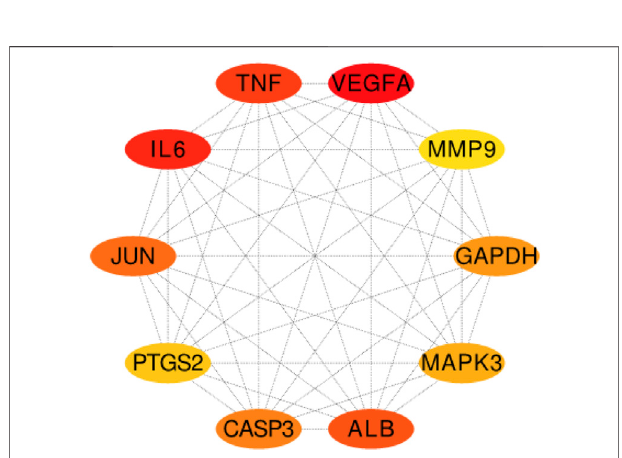
FIGURE 6 | The top 10 Hub target genes of PPI were obtained through MCC function. The color gradually changes from yellow to red; the closer to the red target gene, the more important it is. They are, respectively, P15692 (VEGFA), P05231 (IL-6), P01375 (TNF), P02768 (ALB), P05412 (JUN), P42574 (CASP3), P04406 (GAPDH), MAPK3 (P27361), P35354 (PTGS2), and MMP9 (P14780).